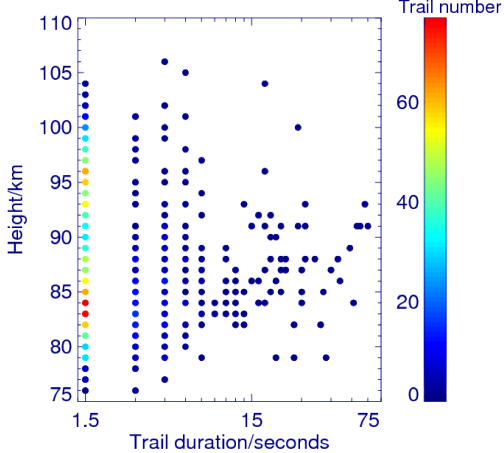
Figure 3. The distribution of the meteor trail duration with the oc- currence height.